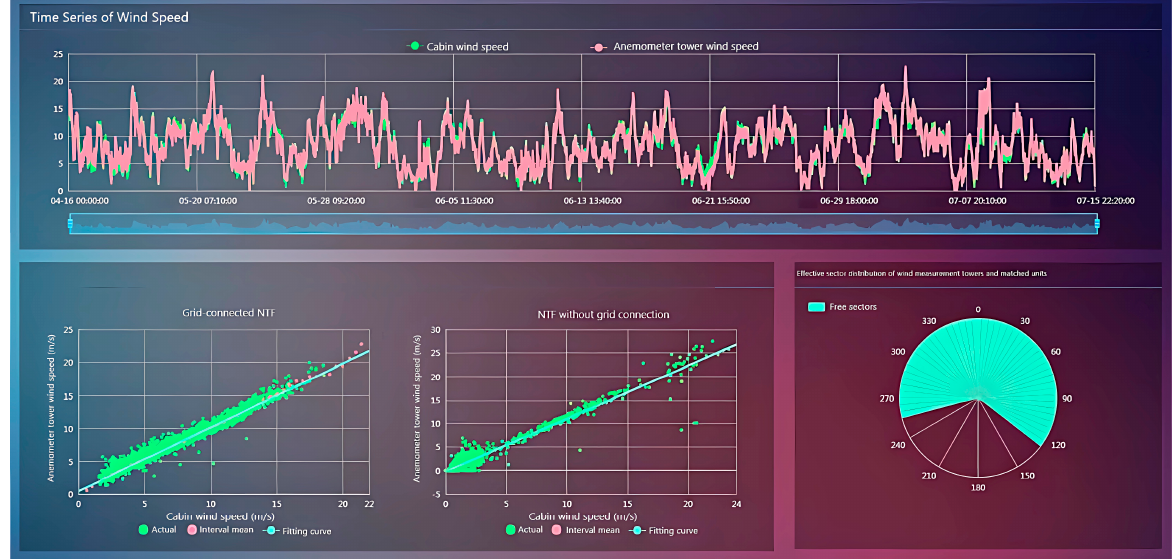
Figure 7. Cabin Transfer Function